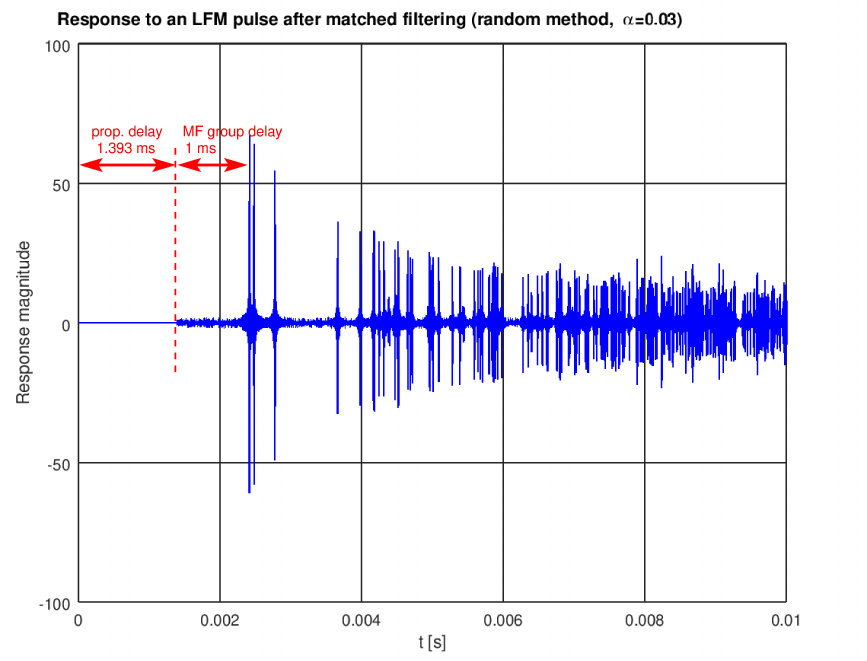
Figure 9. An LFM pulse response after matched filtering in the